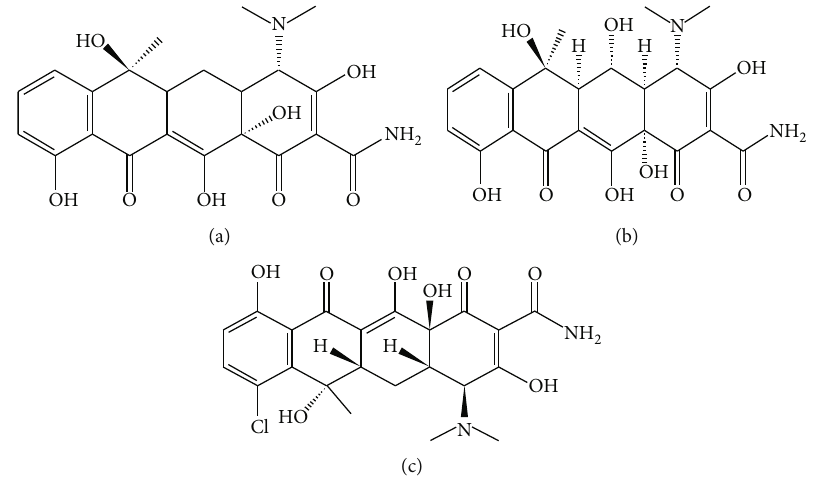
Figure 1: Structures of (a) tetracycline, (b) oxytetracycline, and (c)